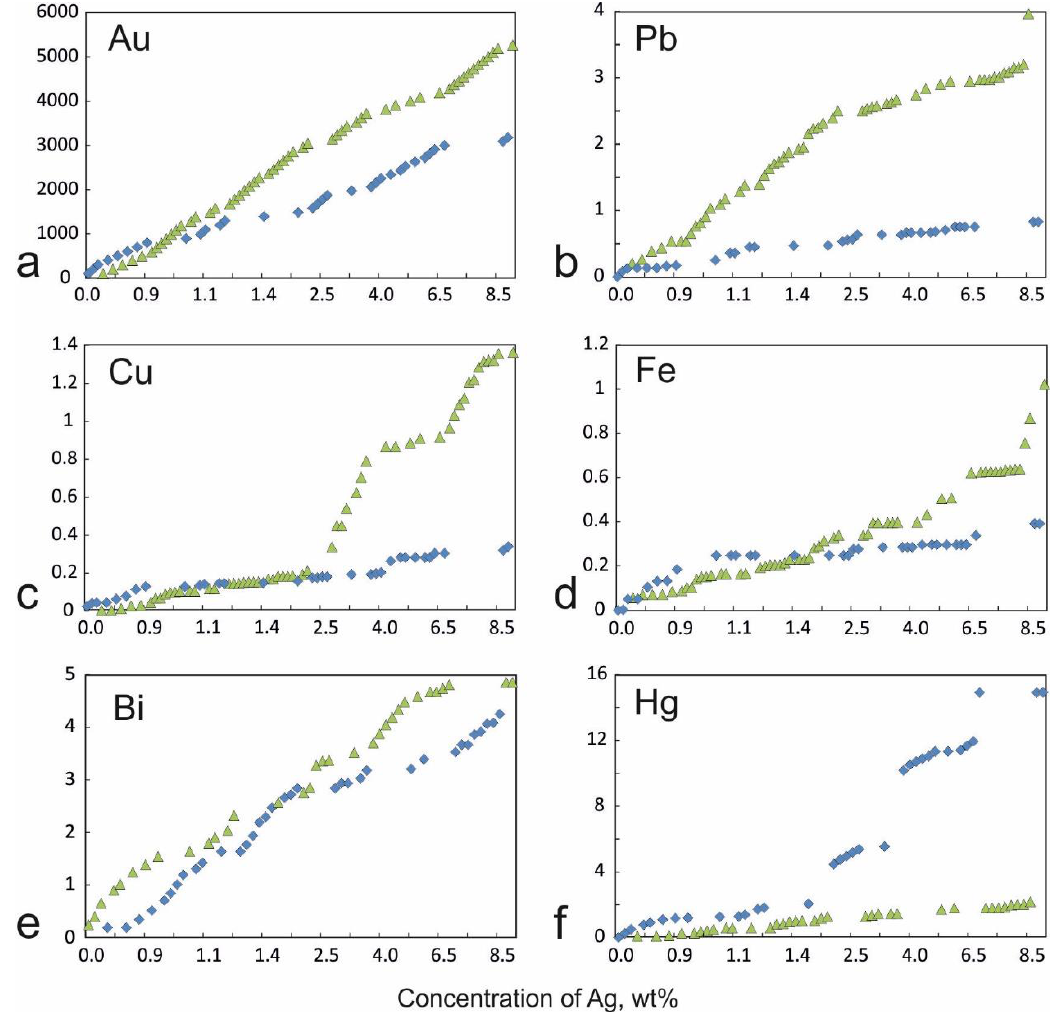
Figure 11. Cumulative plots of trace element (( a ) Au, ( b ) Pb, ( c ) Cu, ( d ) Fe, ( e ) Bi, ( f ) Hg) vs. silver concentrations in massive (green triangle) and porouse (blue rombus) gold of the Khokhoy gold ore field. Table 5. The composition (in wt%) and fineness (in ‰) of the porous gold shown in Figure 11 .